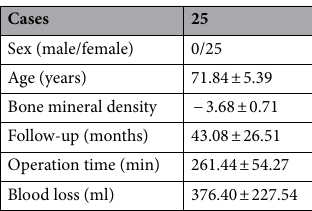
Table 2. Baseline patient data.